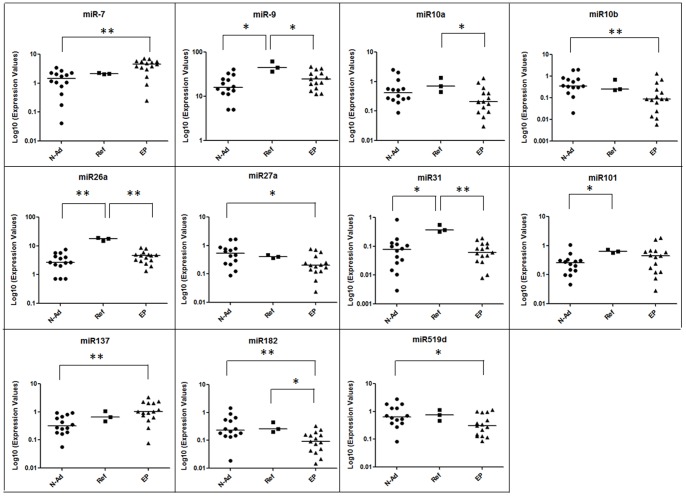
Differences in miRNAs expression.Scatter plots show miRNAs significantly different between groups. Bars indicate median values. * p<0.05, ** p<0.01 according to Mann-Whitney test. The representation of commercial reference (a pool of normal brain RNA) indicates technical variability, while scatter plots of Normal adjacent the tumor and epileptic specimens show individual variability. N-Ad, Normal adjacent the tumor; Ref, Commercial reference; EP, epileptic.